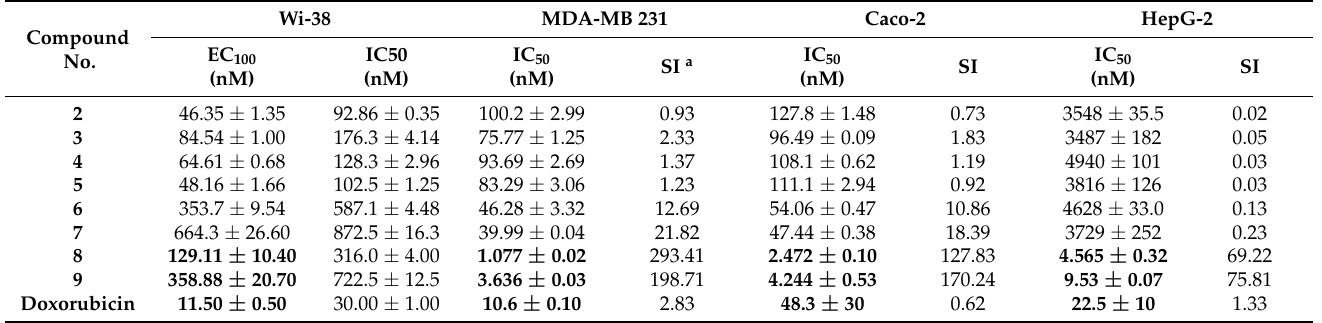
Table 2. Cytotoxicity and anticancer selectivity profiles of the pyrimidine sugar hydrazones 2 – 5 and